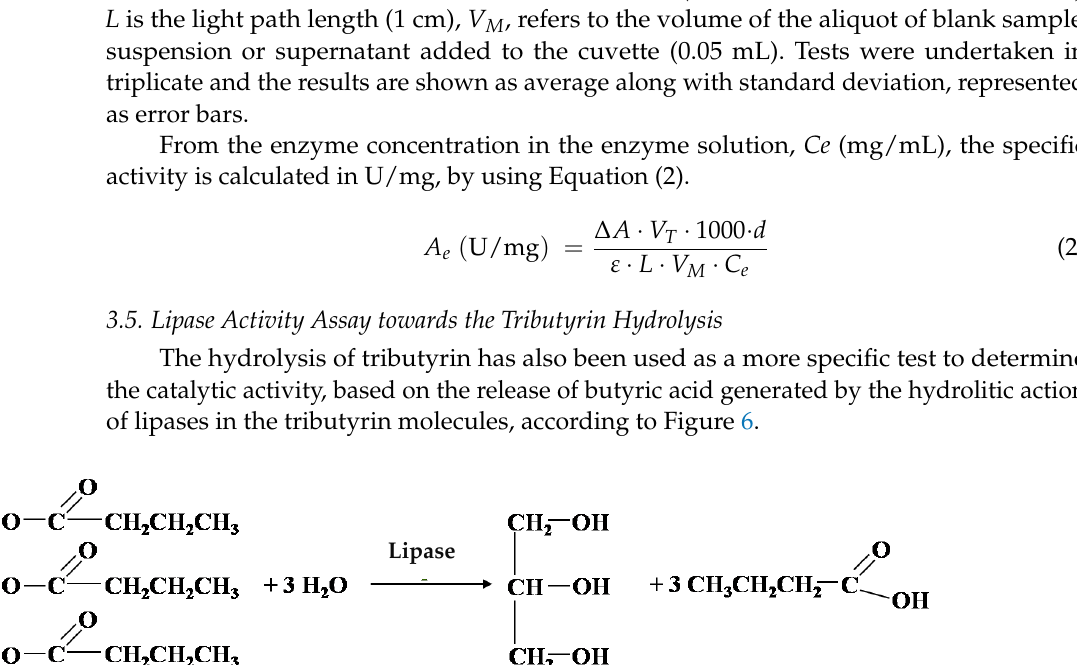
Figure 6. Enzymatic hydrolysis reaction of tributyrin, which generates one molecule of glycerin and three of butyric acid.